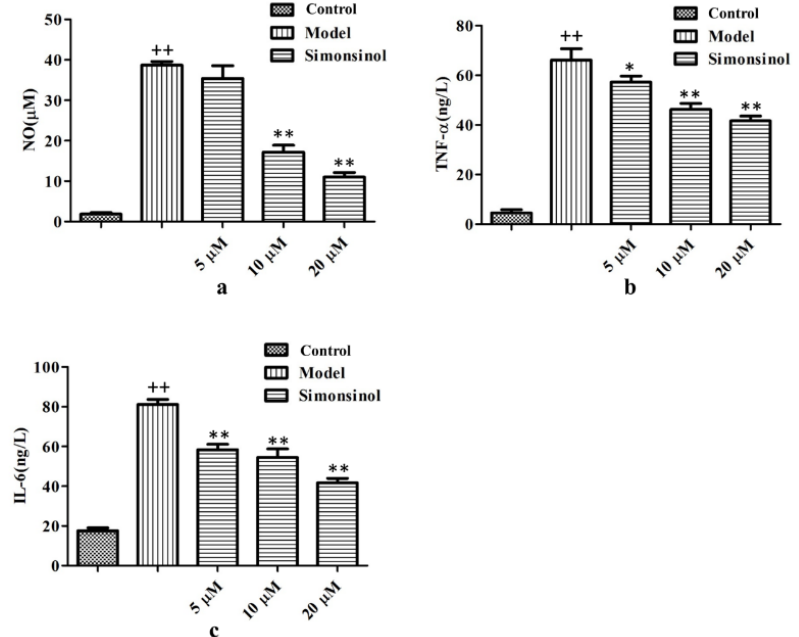
Figure 4. Simonsinol inhibits NO ( a ), TNF- α ( b ), and IL-6 ( c ) secretion in LPS-stimulated RAW264.7 cells. Data are represented as the mean ± SD (n = 3). ++ , highly significant difference compared to blank control cells ( p < 0.01). *, significant difference compared to LPS-stimulated model cells ( p < 0.05), **, highly significant difference compared to LPS-stimulated model cells ( p < 0.01). Molecules 2020 , 25 , x